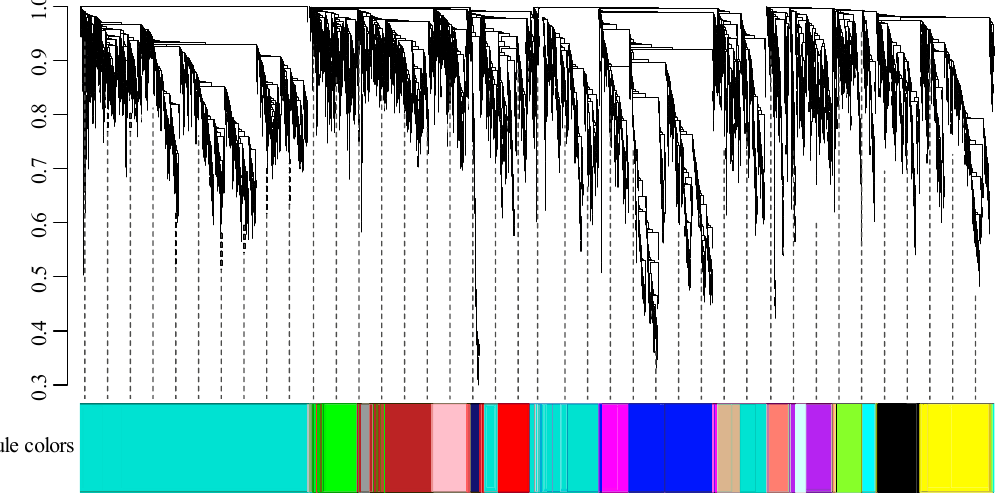
Figure 3. Hierarchical clustering of differentially expressed genes. The y-axis on the clustering indi- cates expression dissimilarity between neighboring genes. Each branch in the clustering represents an individual gene. The colored strips correspond to the module designation for the clusters of co- expressed genes.